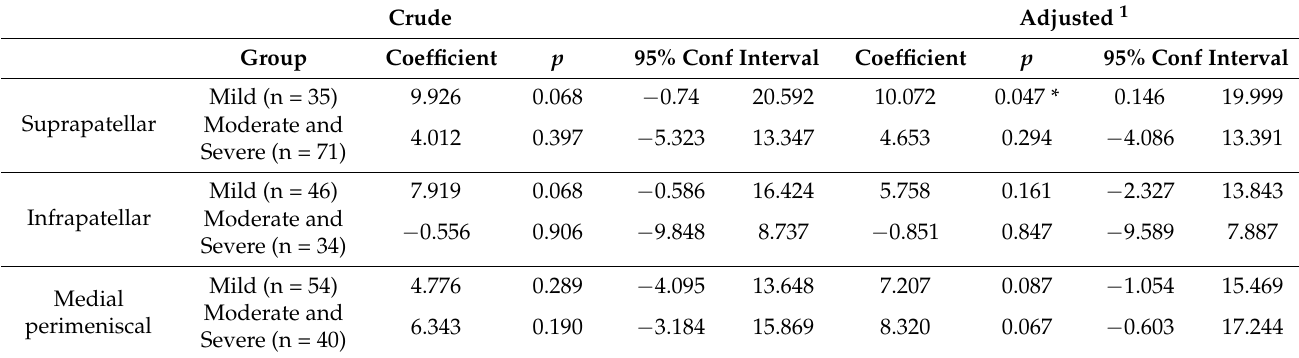
Table 3. Association between site-specific synovial thickness score and knee function.